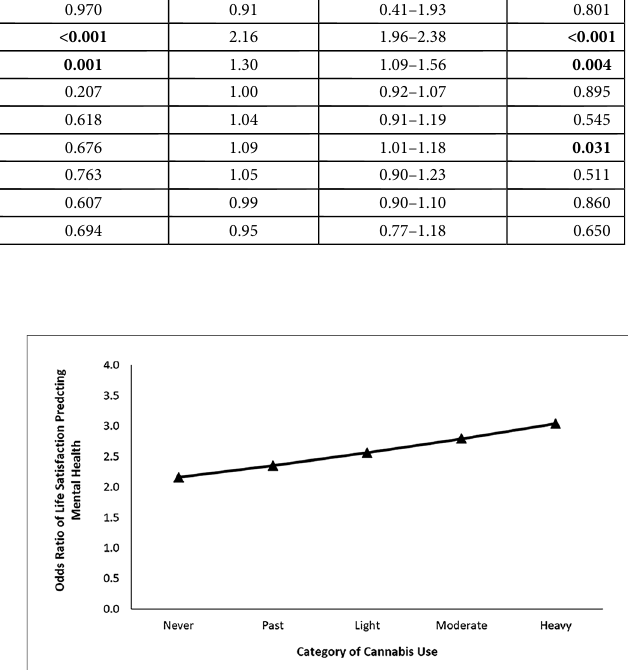
FIGURE 1 Odds ratio of life satisfaction predicting self-reported mental health at each level of cannabis use for females reporting low shame surrounding